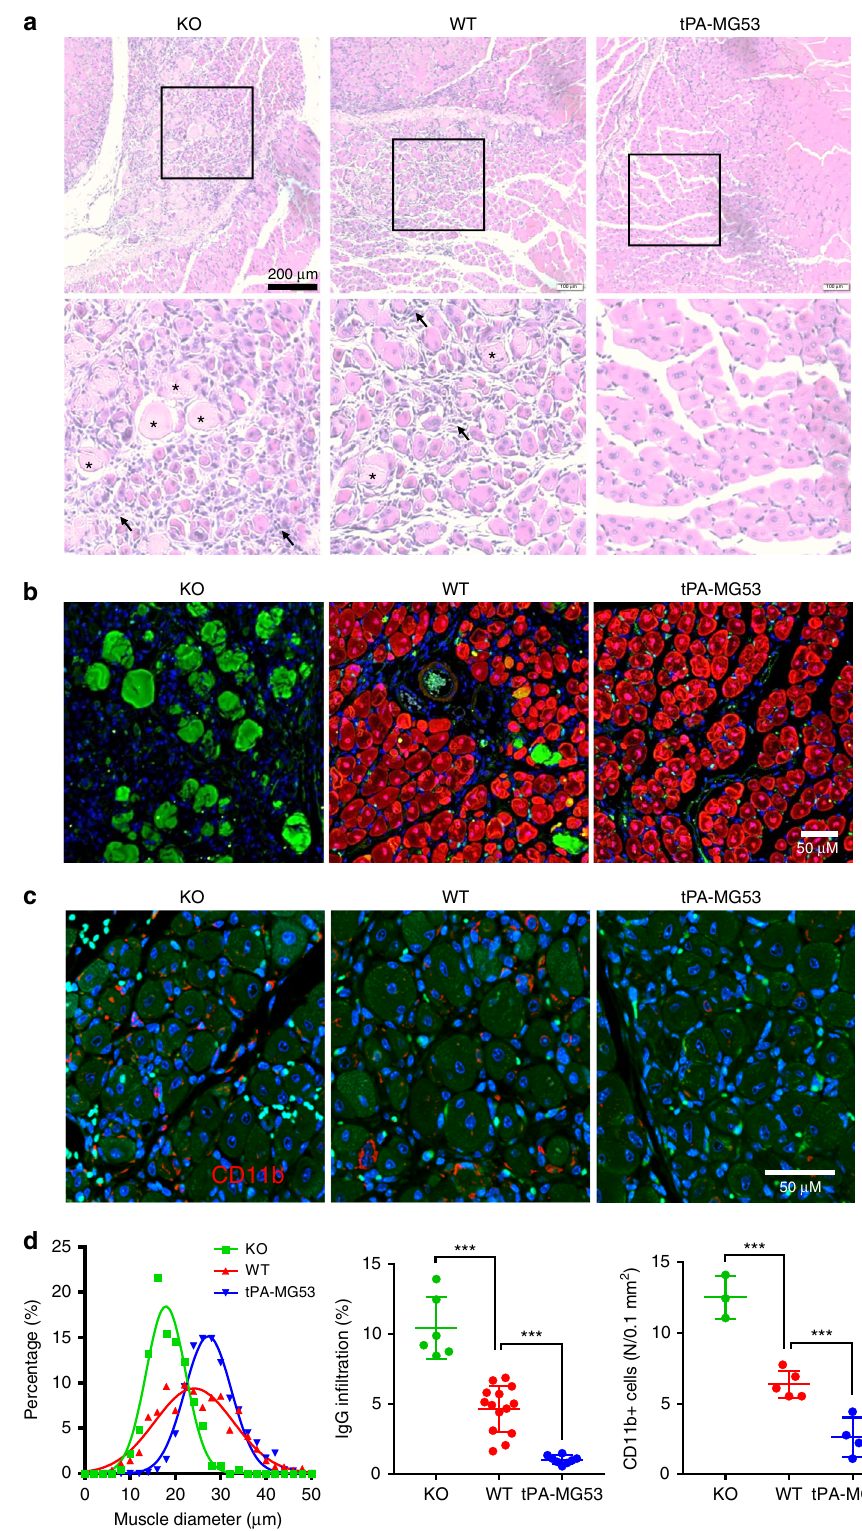
Fig. 5 tPA-MG53 skeletal muscle showed enhanced regeneration capacity after cardiotoxin injury. a H/E staining of gastrocnemius muscle derived from KO, WT, and tPA-MG53 mice at 7 days post cardiotoxin injury. Enlarged pictures show different regenerative capacity of muscle fi bers derived from WT, KO, and tPA-MG53 mice. b IHC staining of MG53 (red) and mouse IgG (green). IgG positive staining, mostly in KO muscle, indicates necrotic muscle fi bers after cardiotoxin injury. c IHC staining with antibody against CD11b to show the different degrees of the presence of immune cells at the muscle injury sites (7 days post cardiotoxin treatment). d Quanti fi cation of muscle fi ber size (left), IgG staining of necrotic fi bers (middle) and number of cells positive for CD11b (right). *** p < 0.001, ** p < 0.01. Error bar represents the standard deviation and p value was generated by t